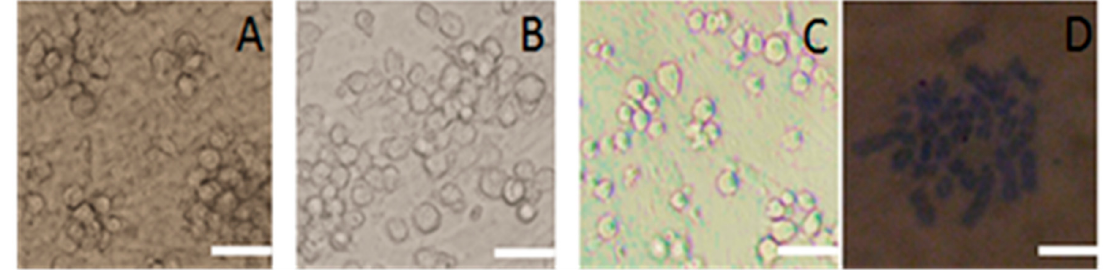
Figure 4. Images of cultured porcine SSCs after repeated subculture and their karyotype. ( A ) Cells in the fifth subculture; ( B ) Cells in the 10th subculture; ( C ) Cells in the15th subculture; ( D ) Karyotype cells in the 15th subculture. Scale bar: 5 μ m.